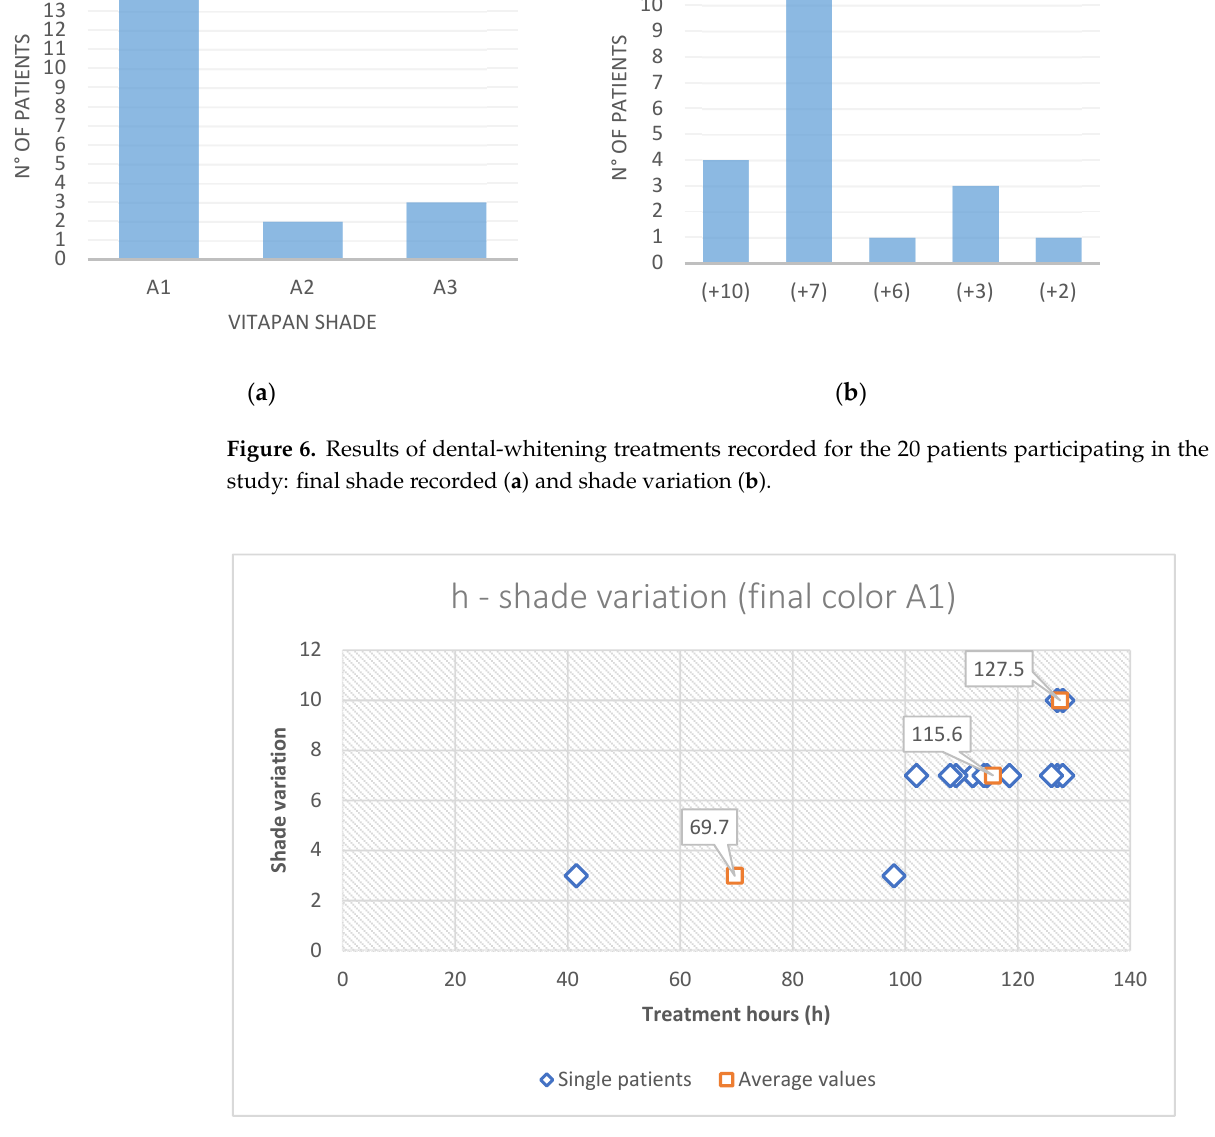
Figure 7. Results correlating shade variation and treatment hours for all the 15 patients that concluded the whitening treatment with A1 shade. The average values of the hours of treatment, for each shade variation reached (3, 7, and 10), are reported (orange squares).